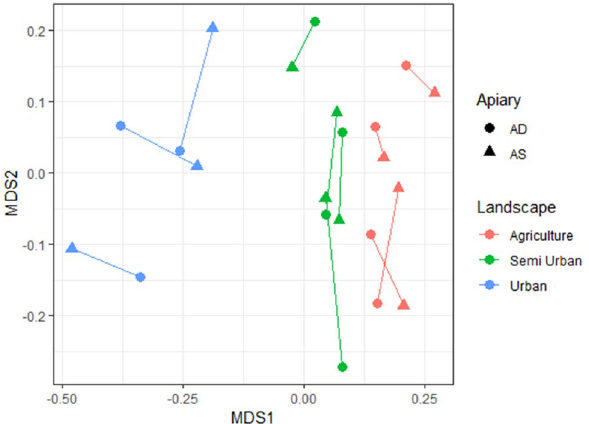
Figure 1. Multidimensional scaling was used to visualize the land cover dissimilarity matrix (calculation based on Euclidean distance). Circles represent AD (apiary dense) site and overlap with AS (apiary sparse) sites (rectangles) and paired sites are connected (showing that paired sites have similar land covers). The landscape types are: urban = blue, agricultural = red, and semi-urban =